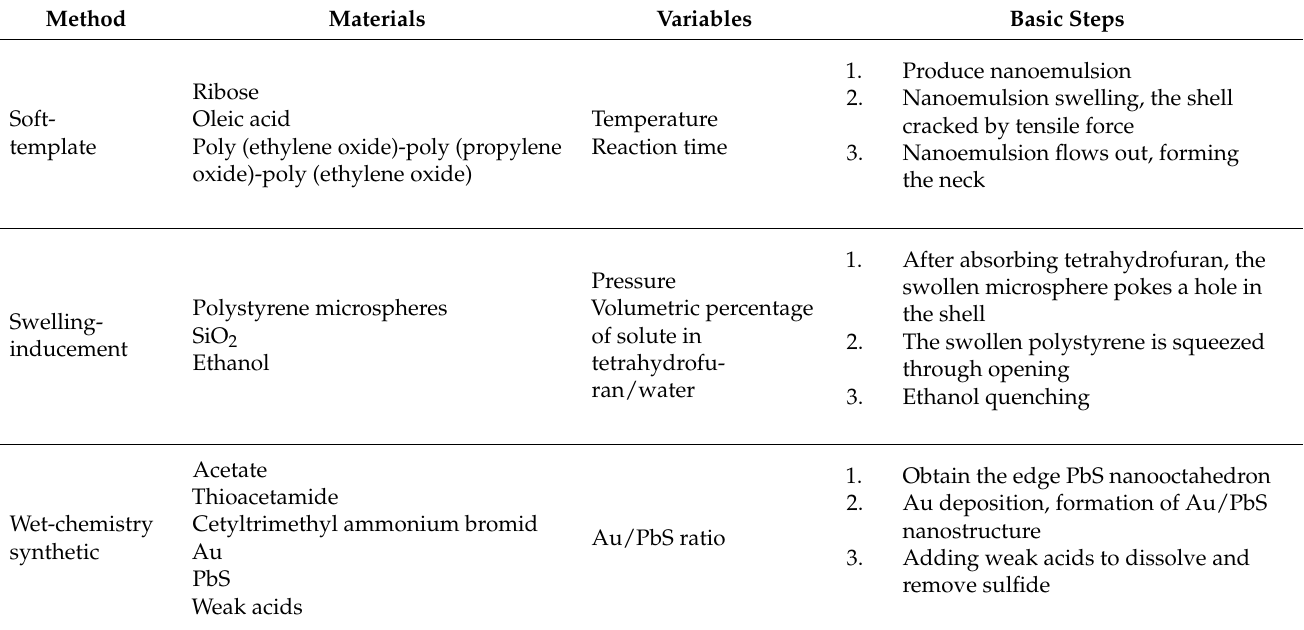
Table 1. The main references of nanobottles